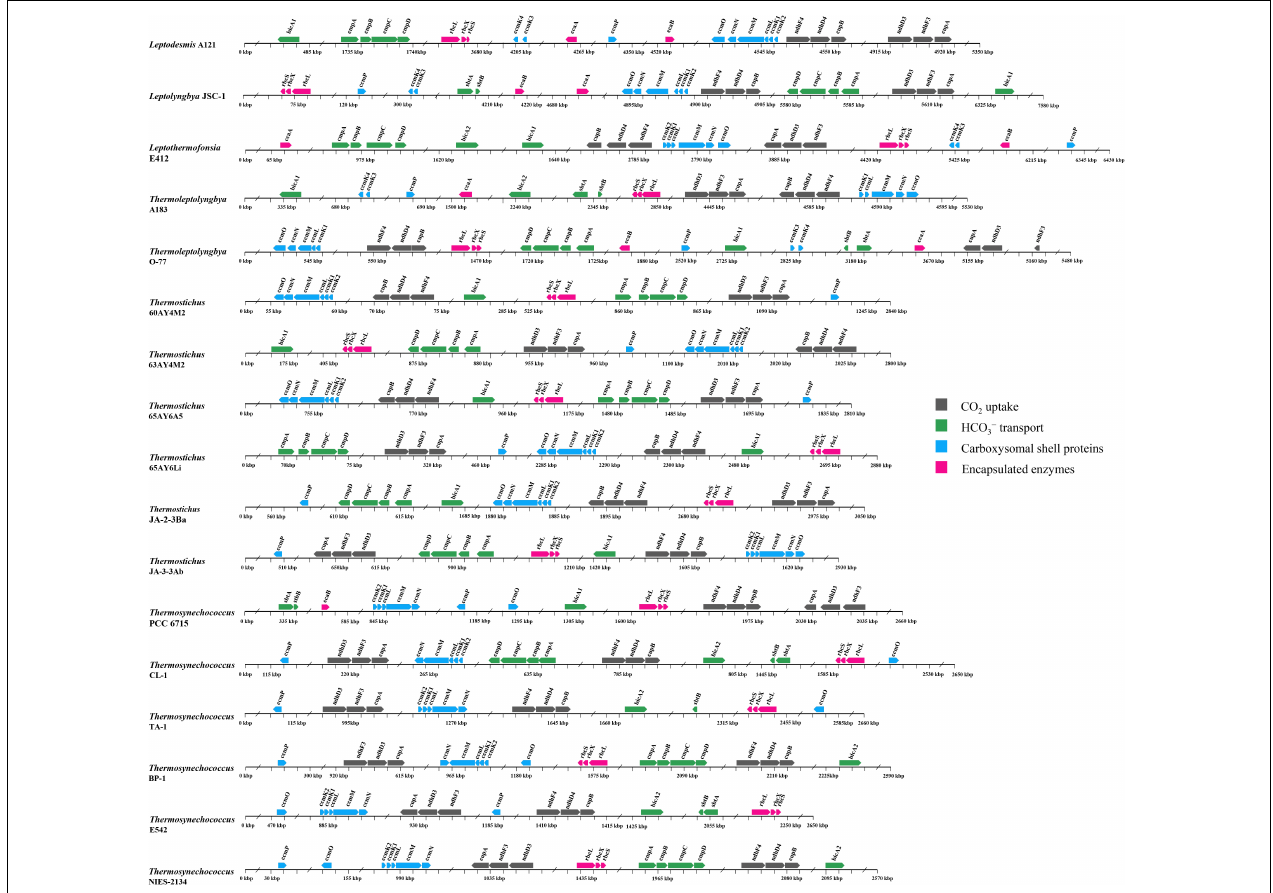
FIGURE 7 | Genomic organization of CCM-related genes in the 17 thermophilic cyanobacteria studied. Solid arrow boxes refer to genes and the direction of